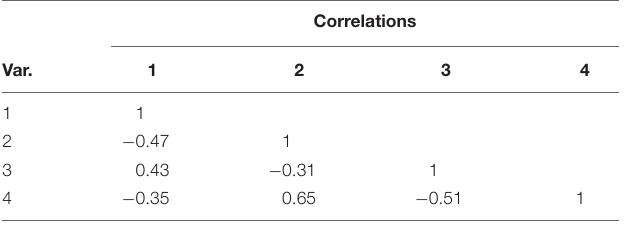
TABLE 3 | Correlations among total scores on interpersonal behavior subscales in the pilot study ( N = 106 couples). a